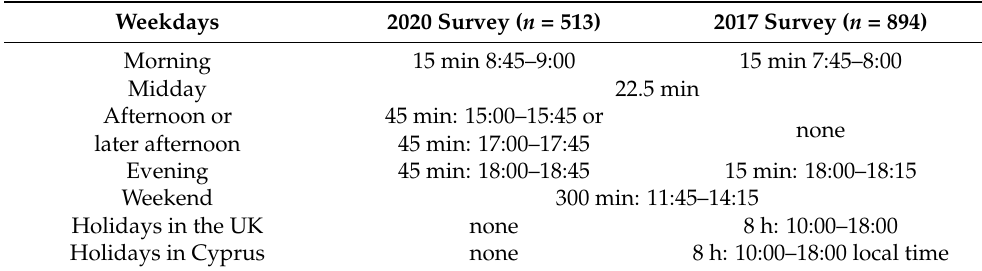
Table 2. The median time spent outdoors and its timing according to 2020 and 2017 surveys. Time is given in BST; except holidays in Cyprus.